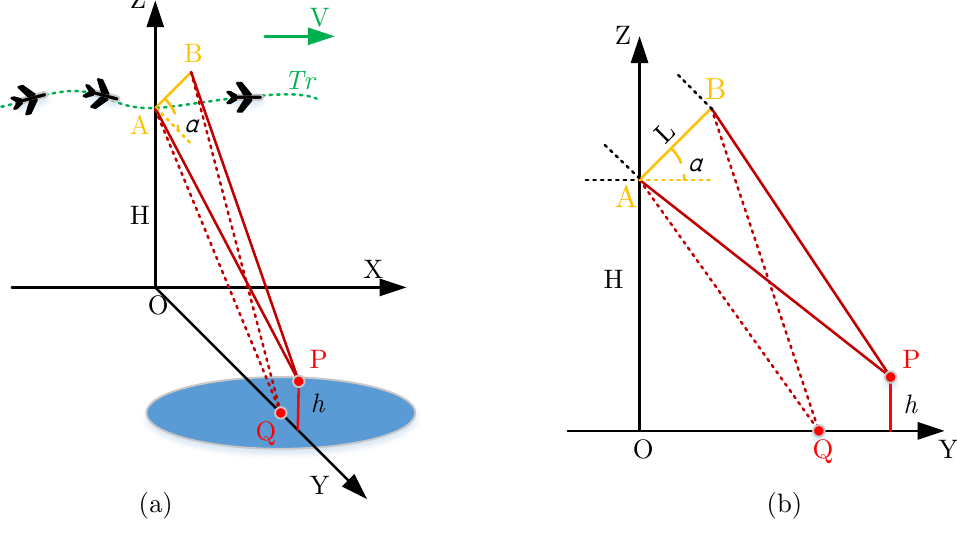
Figure 1. Airborne InSAR system model. ( a ) 3D diagram of InSAR ( b ) lateral